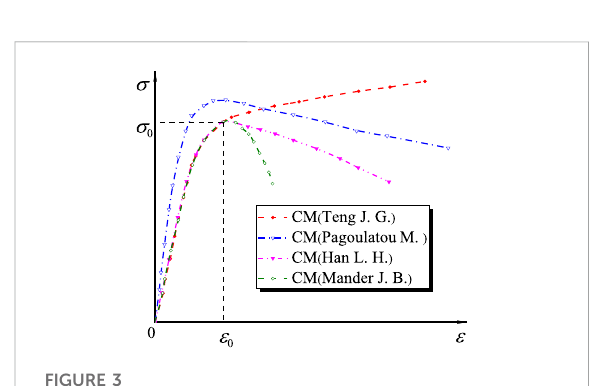
FIGURE 3 The comparison of different constitutive models